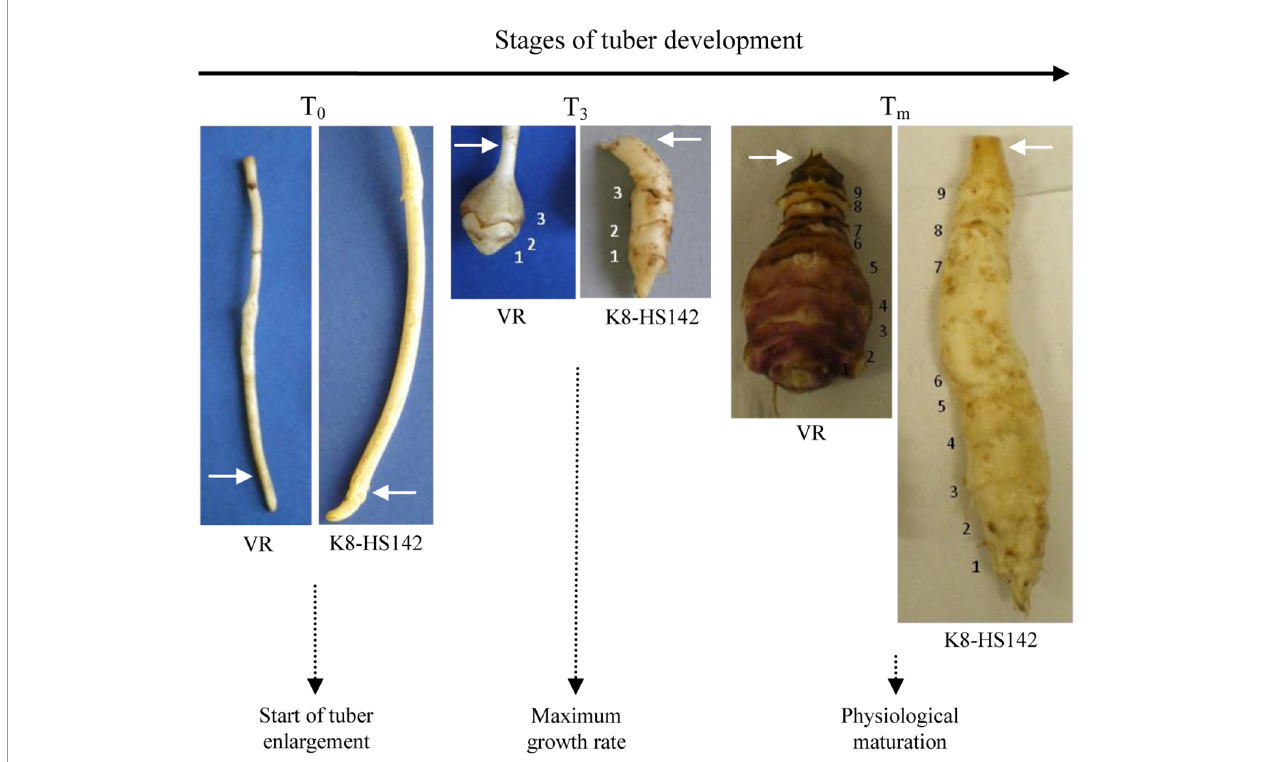
FIGURE 1 | Morphological comparison of the rhizomes of Helianthus tuberosus “ VR ” and “ K8HS142 ” clones during the tuber development. The white arrows point to the initial part of tuber enlargement. The sizes at the three stages are on scale. The number of nodes is